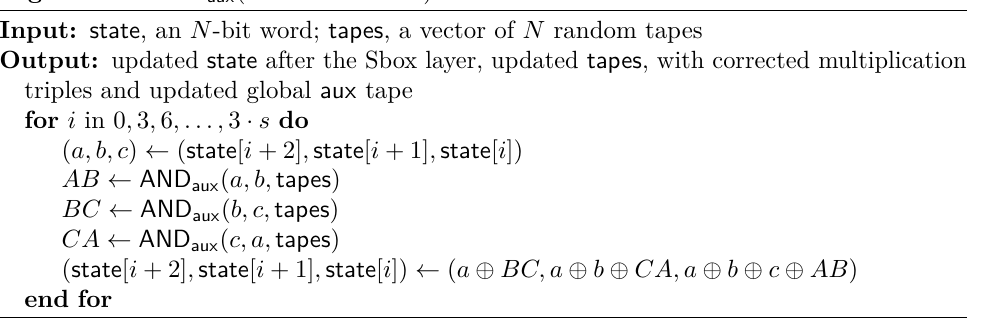
Algorithm 9 sbox aux (after Section